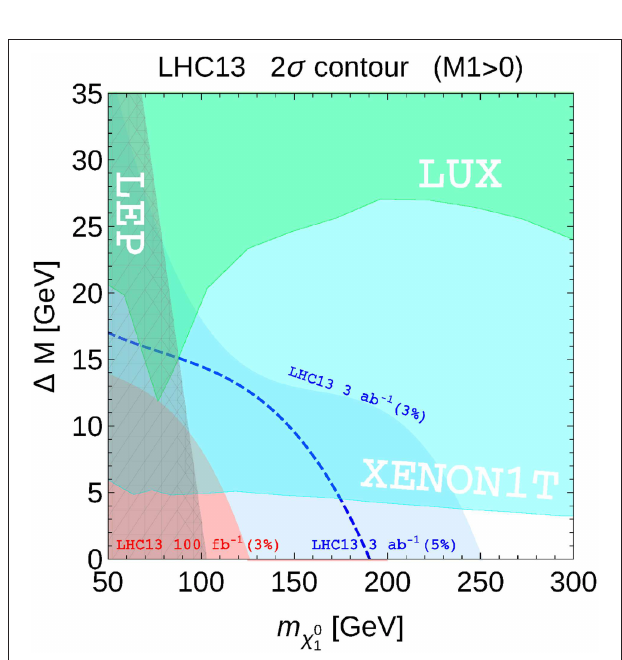
FIGURE 5 | Exclusion contour lines for the 13 TeV LHC at the end of the LHC Run2 (light red region) and of the HL-LHC (light blue region). The region excluded by LUX and Xenon1T are also shown, together with the LEP limit. See details in Barducci et al. [32].